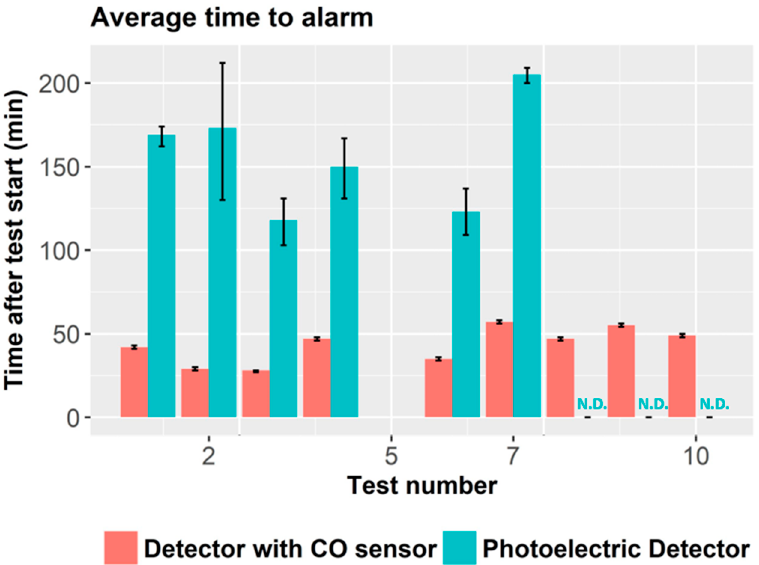
Figure 4. Time to alarm in smoldering fires in the SP Fire Research Experiment. Comparison between photoelectric detectors and multisensory including CO Electrochemical Cell [42]. Photoelectric detector combined with CO sensor always produced faster alarm signals, and it was able to detect all the test fires. Standalone photoelectric detector did not trigger the alarm for three of the fires (not detected [N.D.]). Experiment #5 was not considered in the study as the fire developed to open fire.